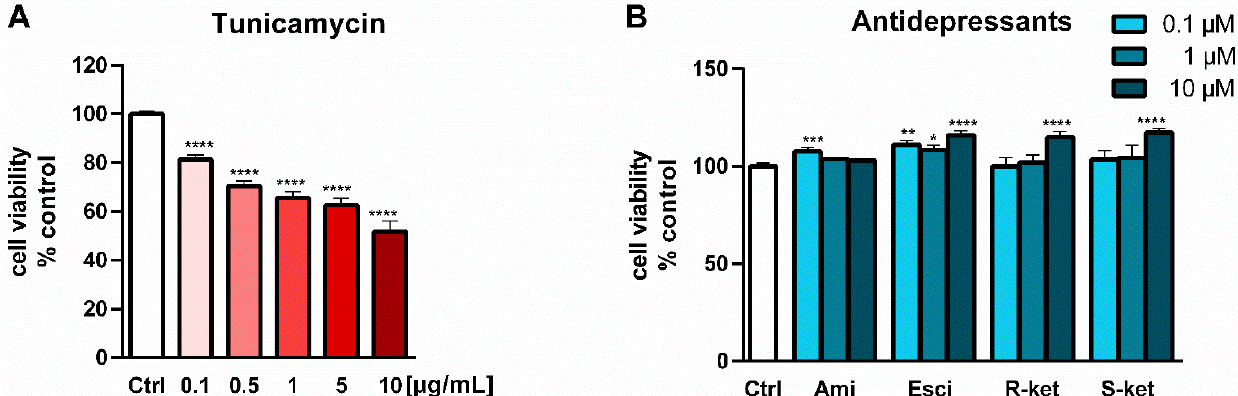
Figure 2. Designing an experimental model for further research work: Effect of tunicamycin (0.1–10 µg/mL) on the viability of astrocytes ( A ). Effects of amitriptyline (Ami), escitalopram (Esci), R-ketamine (R-ket) and S-ketamine (S-ket) on the viability of astrocytes after 24-h incubation ( B ). Data are presented as the mean ± SEM and expressed as a percentage of untreated control cells. Statistical significance vs. control cells is indicated when appropriate; * p < 0.05; ** p < 0.01; *** p < 0.001; **** p < 0.0001.